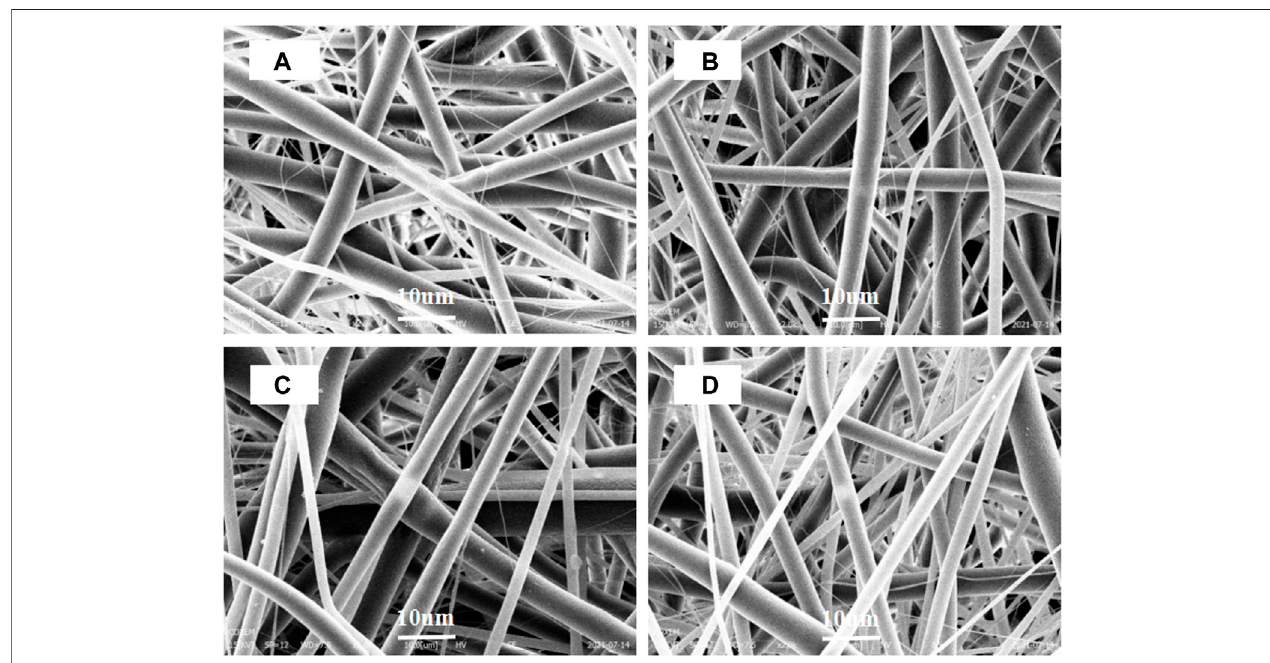
FIGURE 6 | DSC curves of sc-PLA electrospun membranes with different AgNP contents.